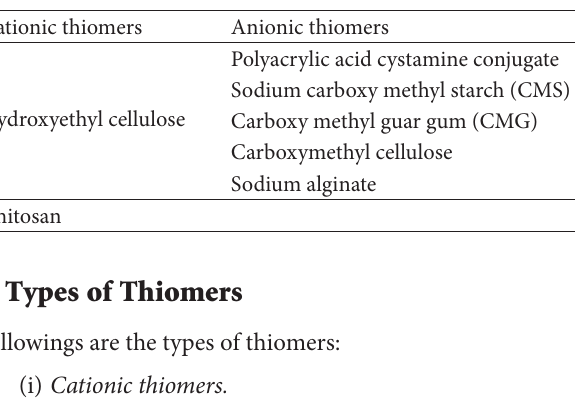
Table 1: Examples of cationic and anionic